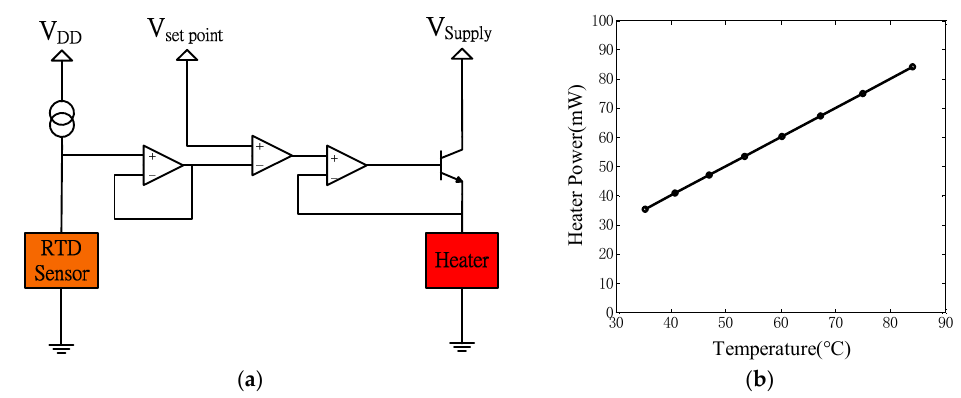
Figure 4. ( a ) temperature control circuit of the heater; and ( b ) power consumption vs. operating temperature of the microheater for the flexible gas sensor array.